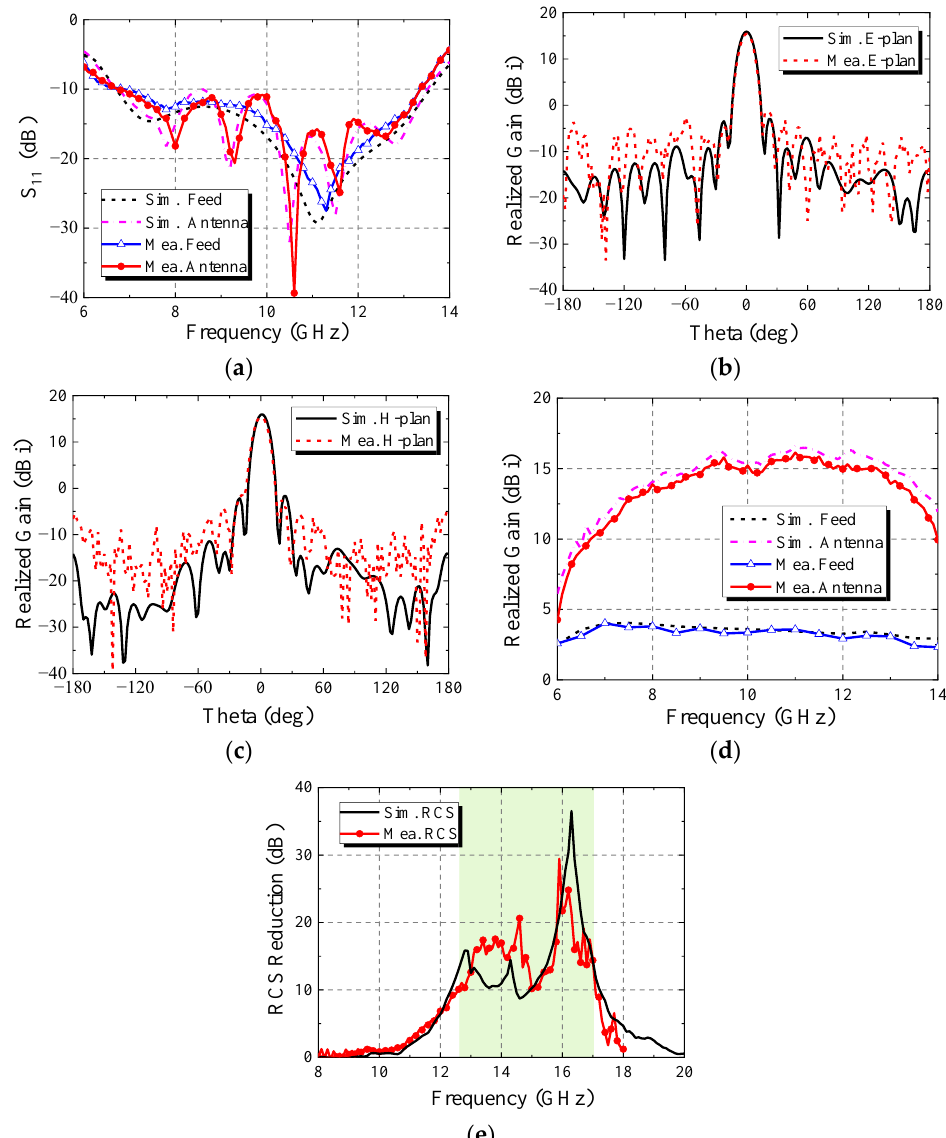
Figure 20. Comparison between simulation results and measurement results: ( a ) S 11 curve; ( b ) radiation pattern of E-plan at 10.5 GHz; ( c ) radiation pattern of H-plan at 10.5 GHz; ( d ) maximum radiation direction gain; ( e ) RCS reduction.